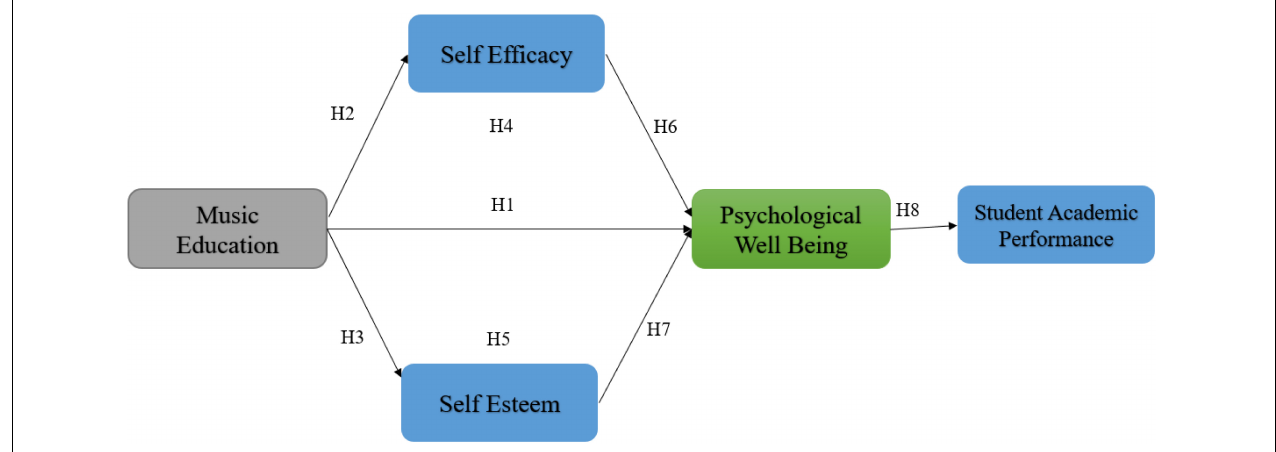
FIGURE 1 | Conceptual